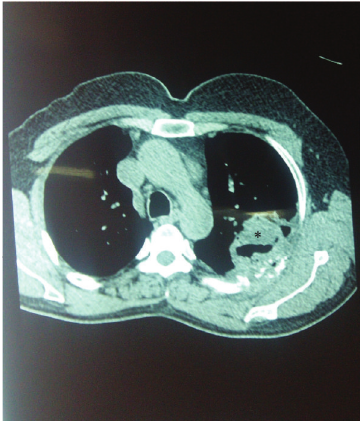
Figure 2: CECT chest showing the pulmonary cavity (pointed by the asterisk).